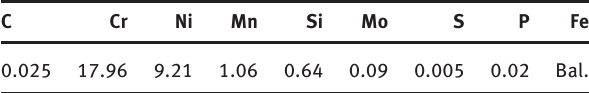
Table 1: Chemical composition of the 304 stainless steel